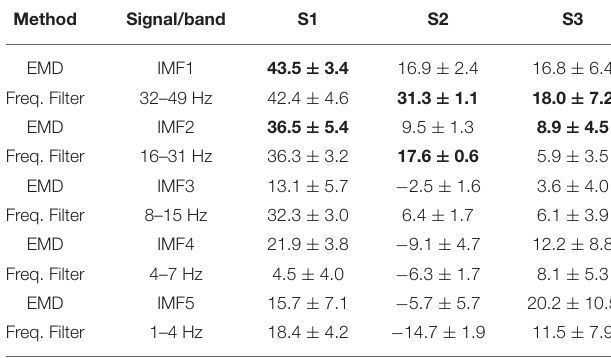
TABLE 1 | Descriptive statistics of the variation of power for the first 5 IMFs averaged through the 10 trials.